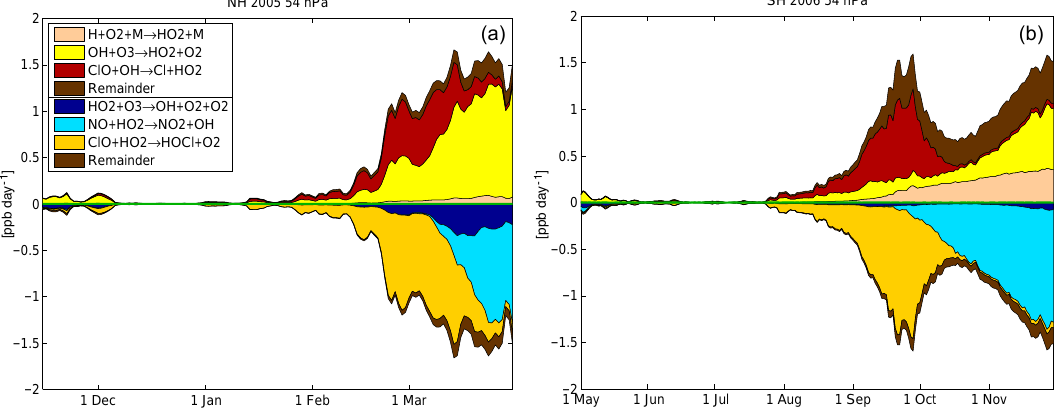
Figure 10. Vortex-averaged chemical reaction rates of reactions changing HO 2 for the Arctic winter 2004–2005 (a) and the Antarctic winter 2006 (b) at 54hPa to illustrate HO x partitioning. Production reactions are shown as positive and are separated by a line in the legend from the loss reactions, which are shown as negative. The net change of HO 2 is shown as a green